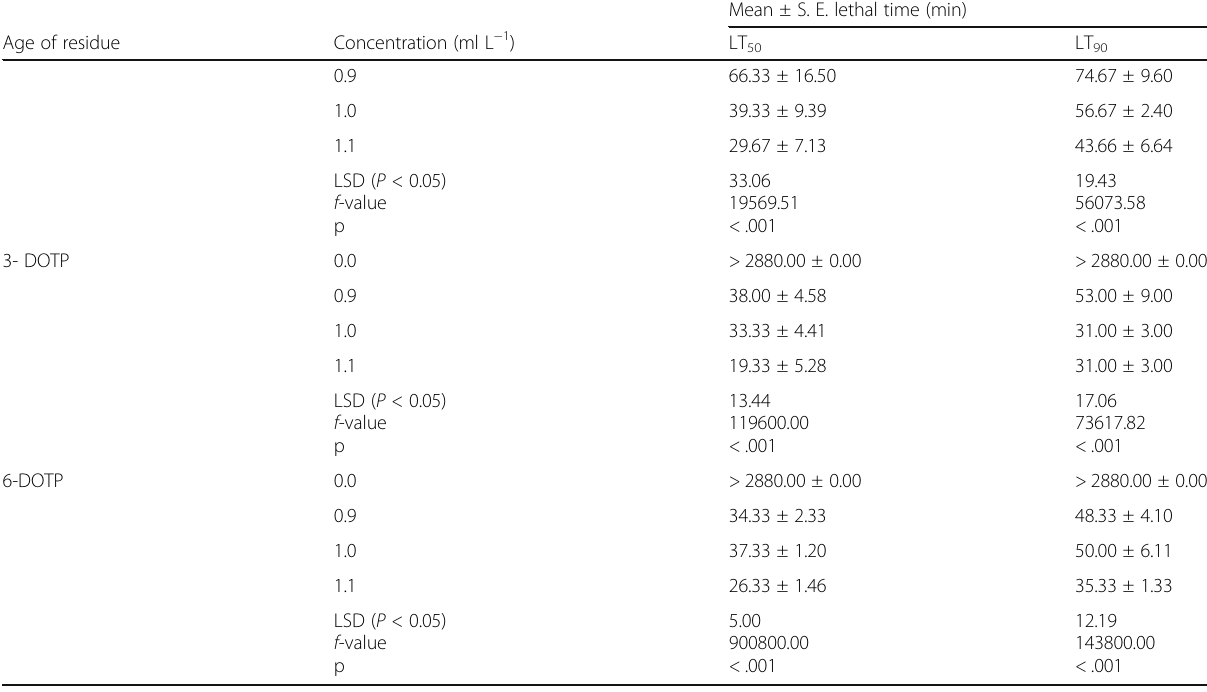
Table 3 Mean lethal time (LT) for different concentrations of chlorpyrifos (Pyrinex) and age of